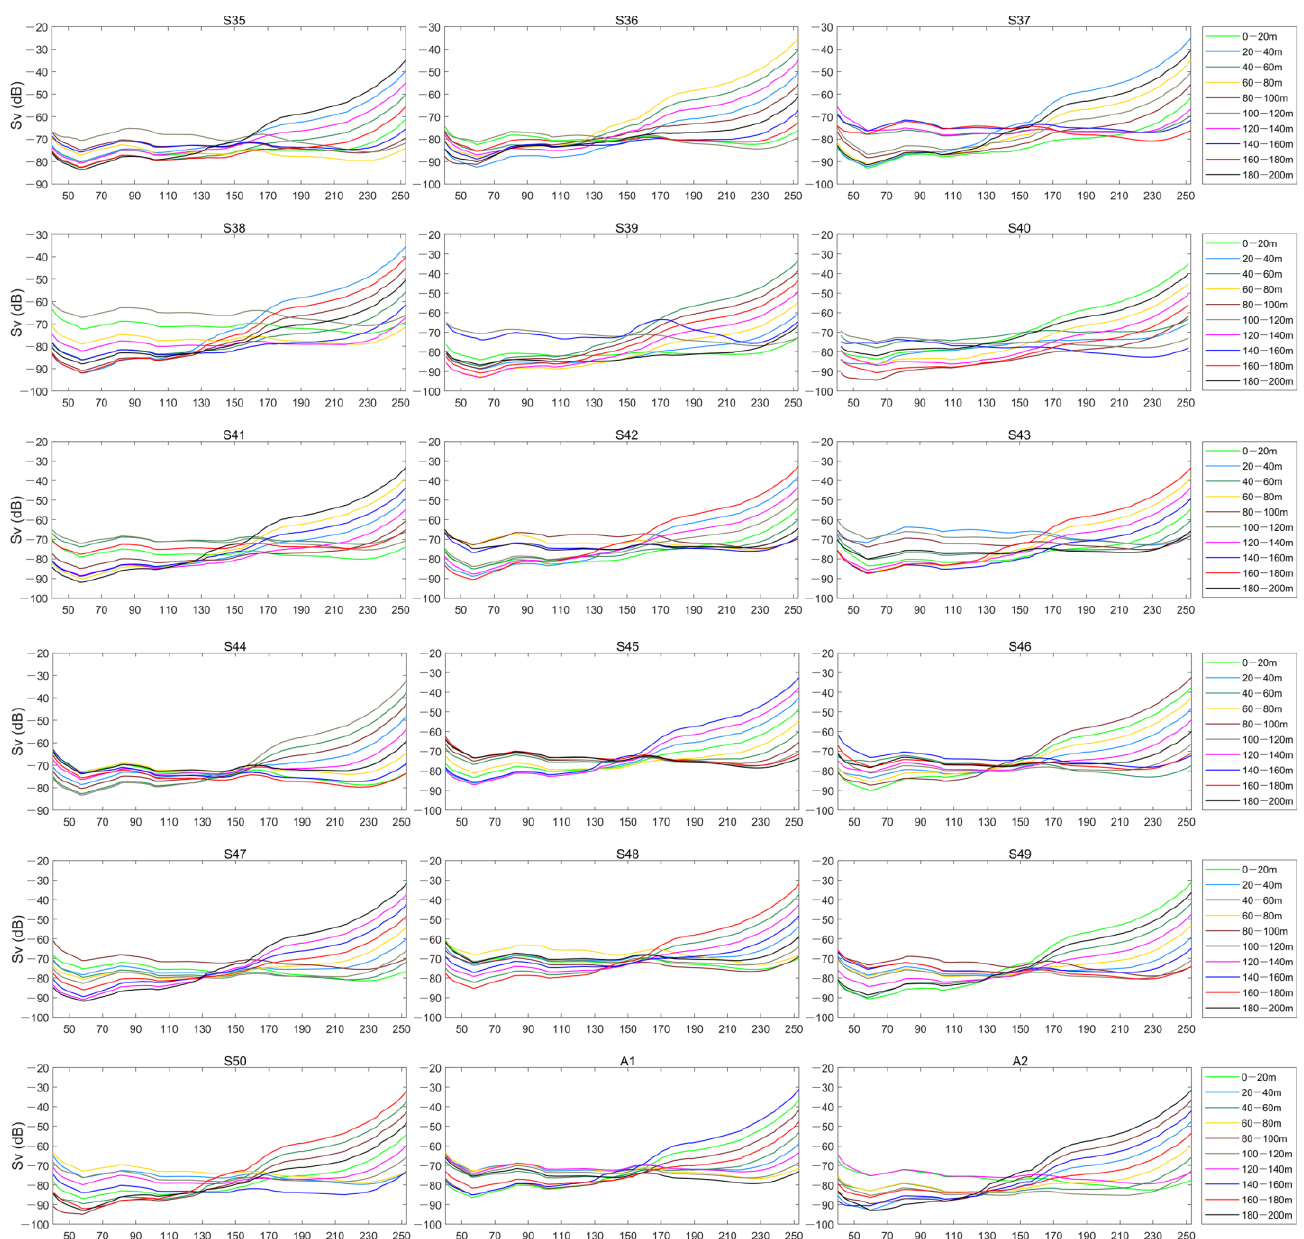
Figure 2. Scattering strength variation with frequencies at all layers in the water column for 30 stations (m: meter, the unit of depth).